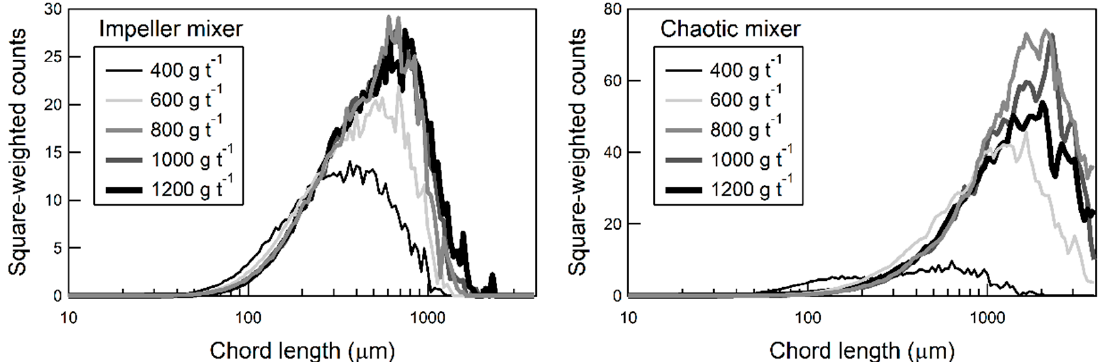
Figure 5. Length square-weighted chord length distributions for 20 wt % kaolin as a function of Magnafloc ® 336 dosage for the two mixers.